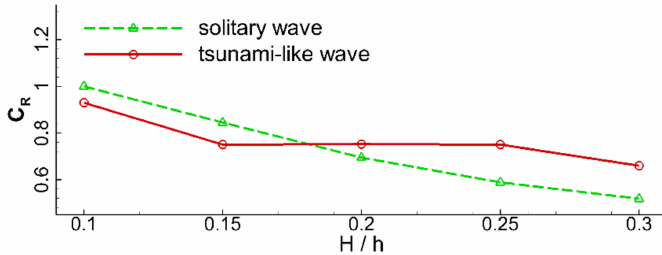
Figure 20. Comparison of variations in wave reflection coefficients with incident wave height.